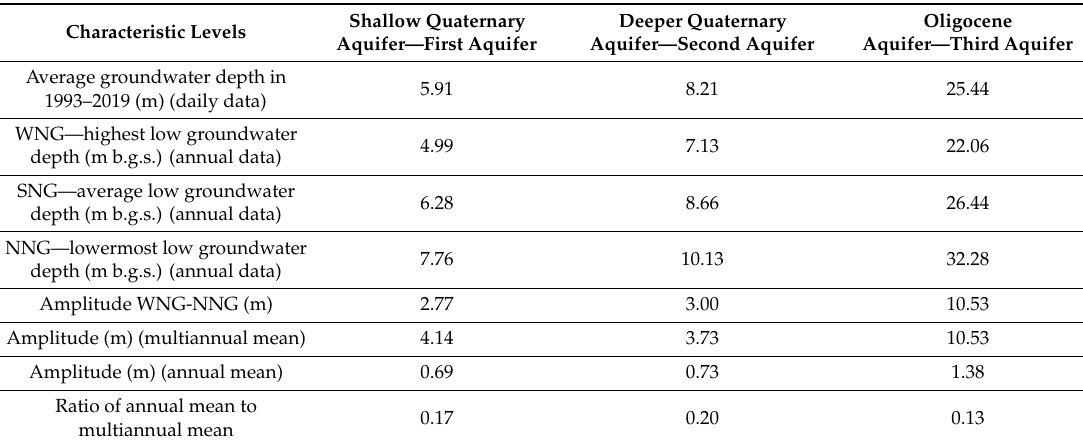
Table 2. Characteristic groundwater levels.